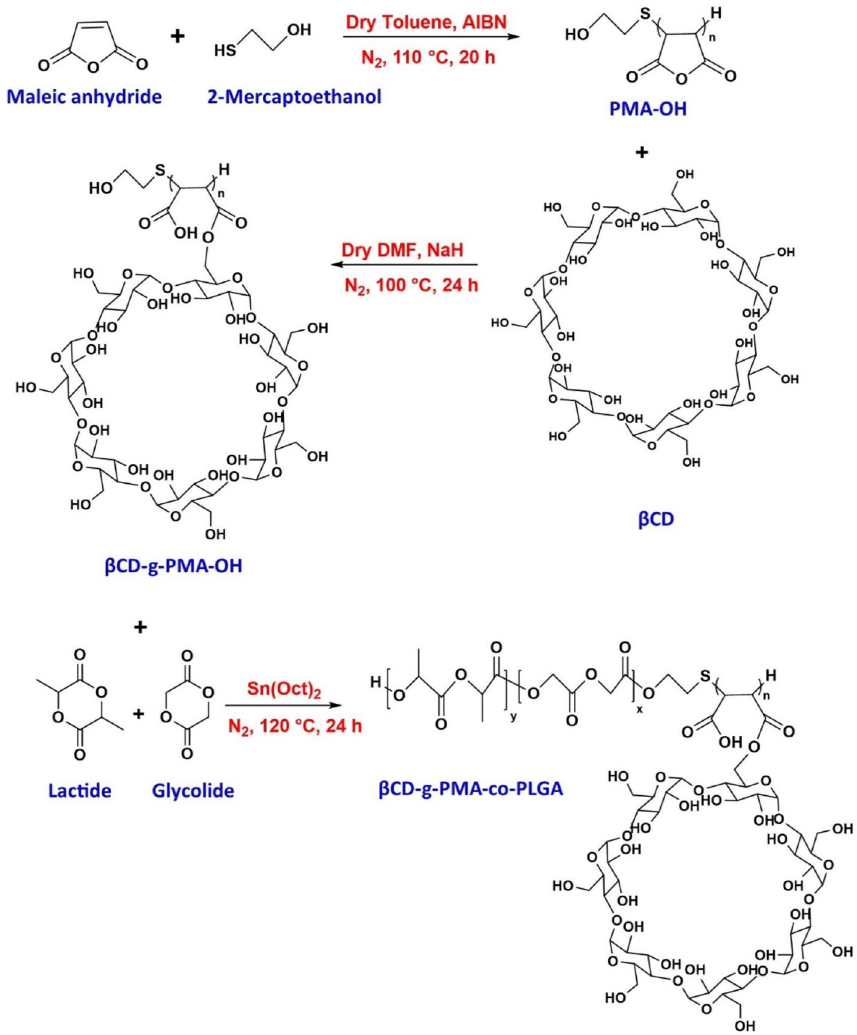
Figure 2. The synthesis pathway of copolymer in three stages: (top row) PMA-OH synthesis with radical thiol-ene addition and maleic anhydride (MA) polymerization, (middle row) βCD-g-PMA-OH synthesis by βCD-grafting with MA ring opening, and (bottom row) βCD-g-PMA-co-PLGA preparation with ring opening of lactide and